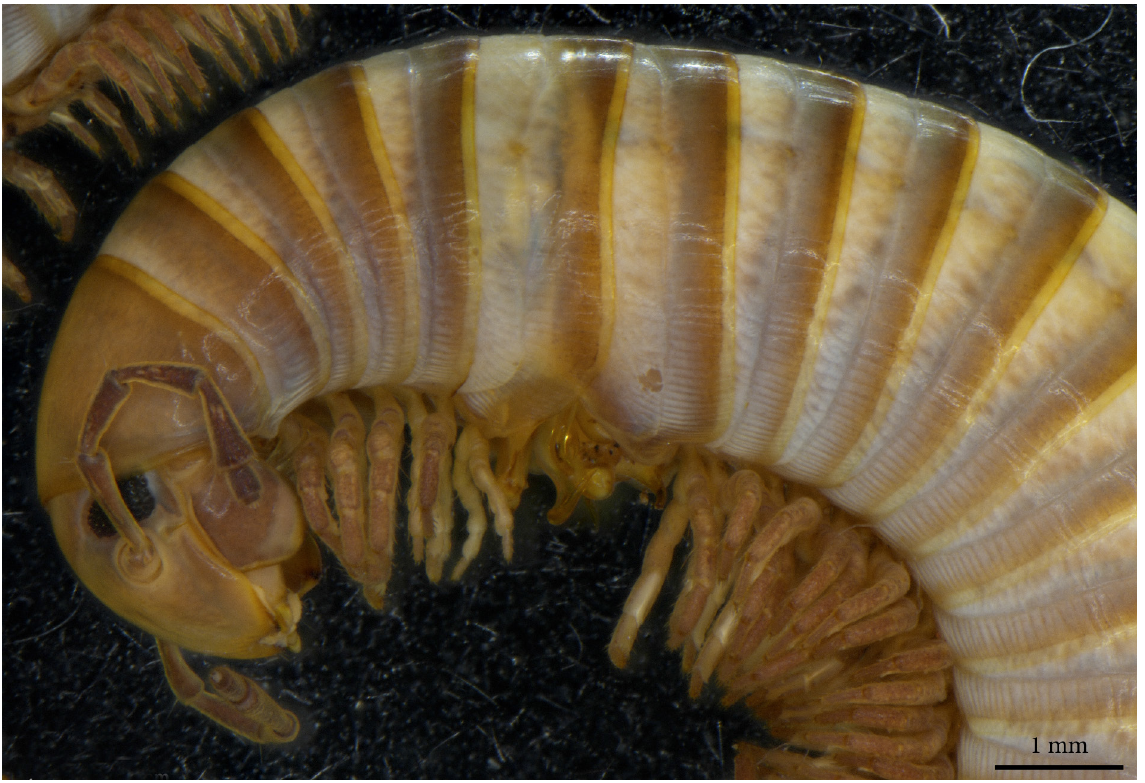
Fig. 11. Ommatoiulus fuentei (Brolemann, 1920), ♂ from Mourão, head and anteriormost body rings, lateral